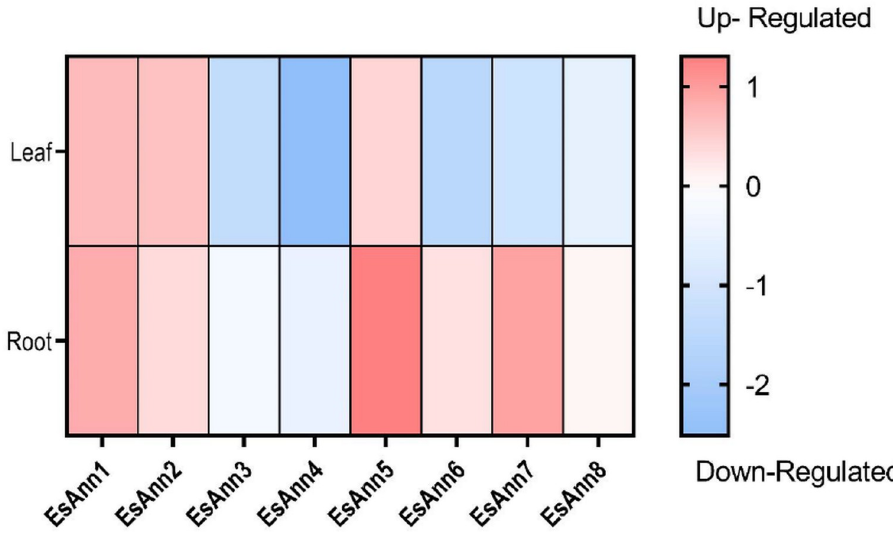
Fig 7. Expression pattern of E . salsugineum Anns under salt stress treatments. The gradient bar indicates the expression value of log2FC. Thirty days after germination, E . salsugineum seedlings were treated with 300 mM NaCl and after 24 h, leaves and roots were separately